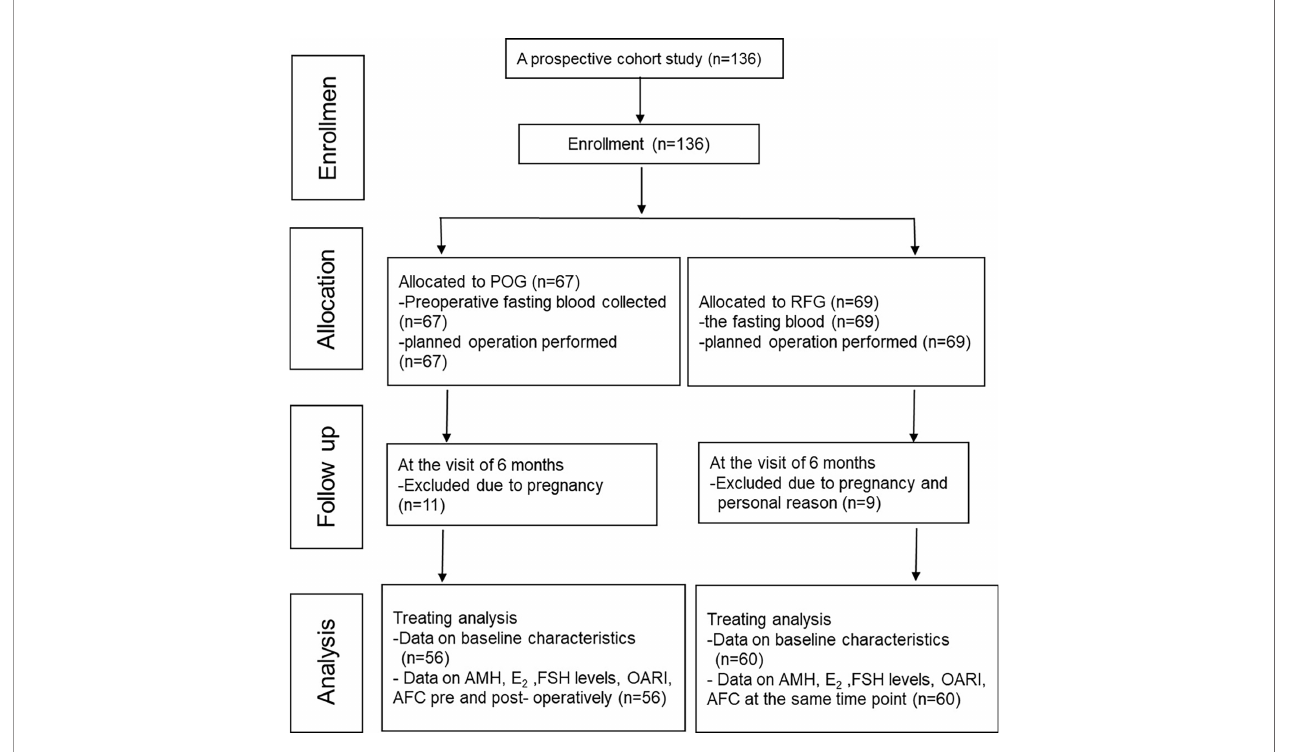
FIGURE 1 | Enrollment, randomization, and follow-up of the study